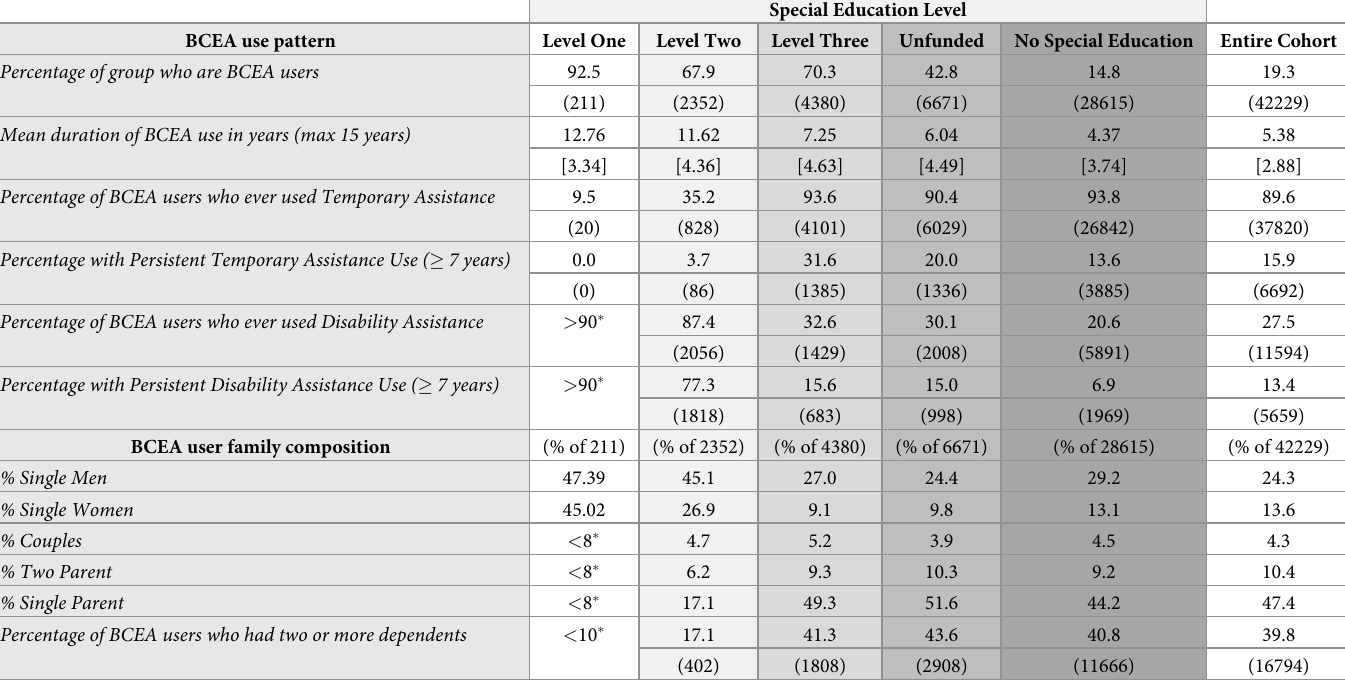
Table 3. BC Employment Assistance (BCEA) use by special education level. BCEA use is described among those who use the two streams of this program, Disability Assistance and Temporary Assistance. Percentages are reported, with number of individuals in parentheses and standard deviation in square brackets.